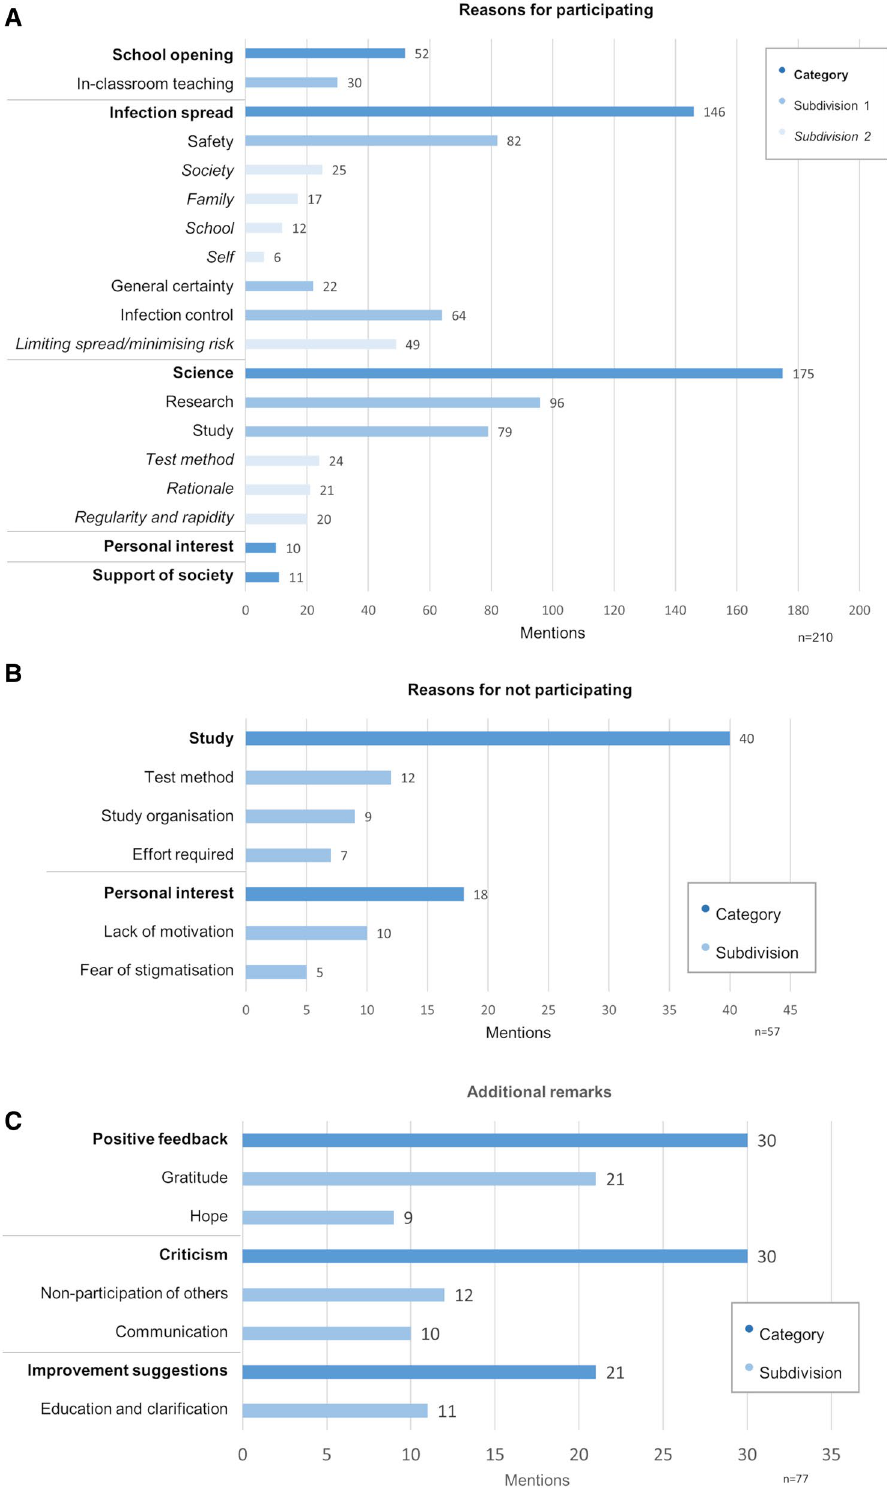
Figure 6. Reasons given in Questionnaire 3 for participants’ decision over participation. ( A ) Reason given for participating in the testing programme. (N = 210 respondents). ( B ) Reasons given for choosing not to participate in the testing programme. (N = 57 respondents). ( C ) Additional remarks provided by respondents. (N = 77